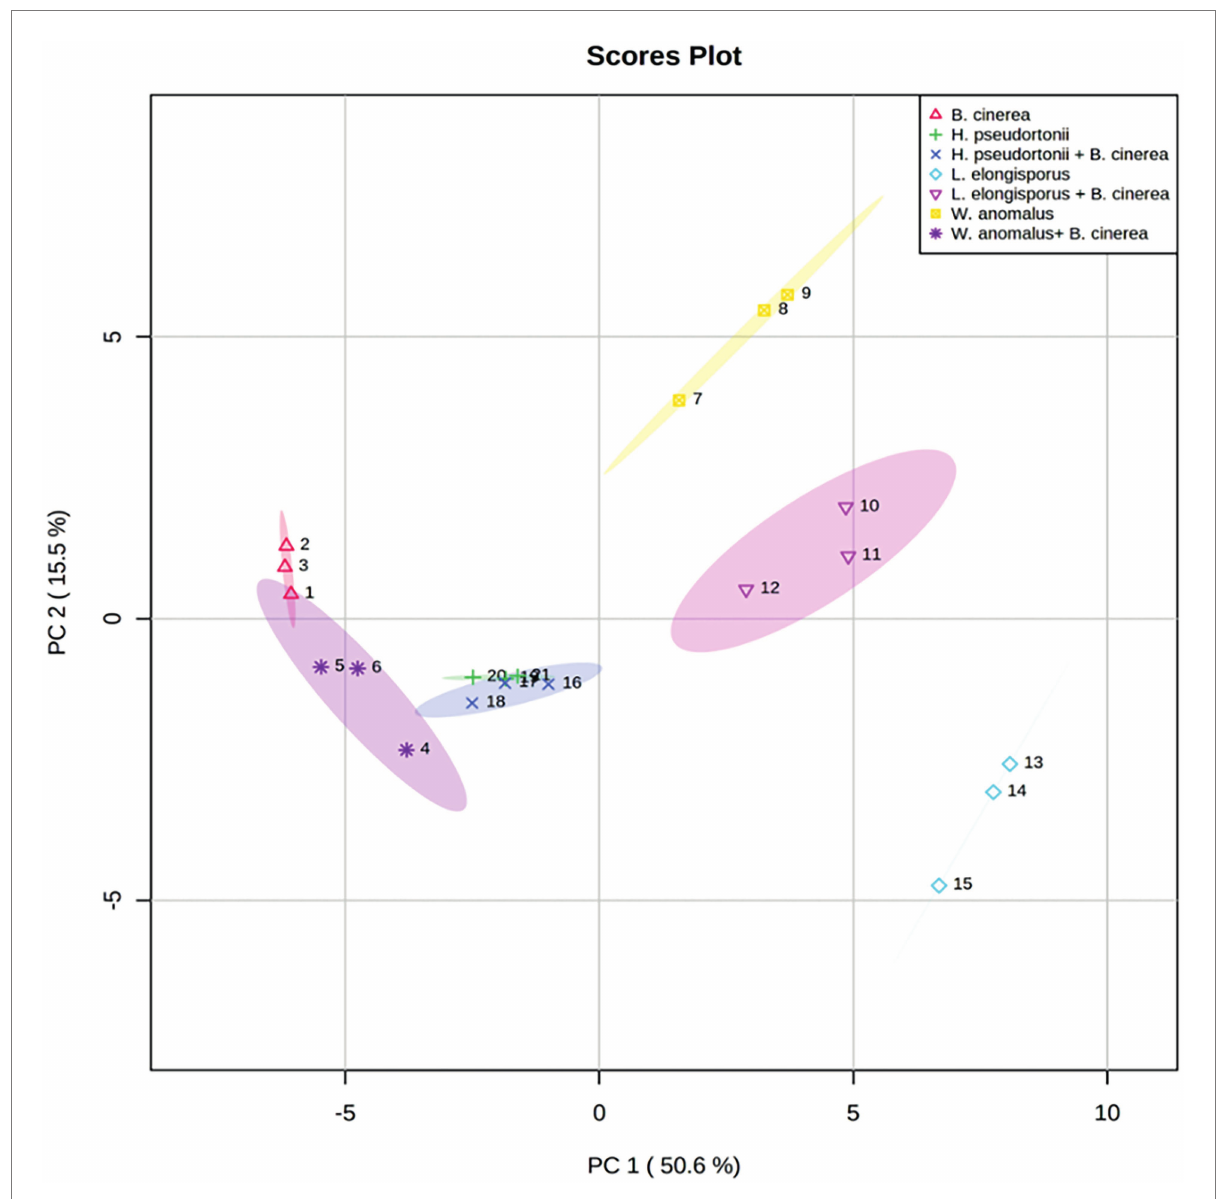
FIGURE 5 Principal component analysis score plots obtained from the non-volatile organic compounds profile of Botrytis cinerea and Botrytis cinerea co-cultured with various yeast